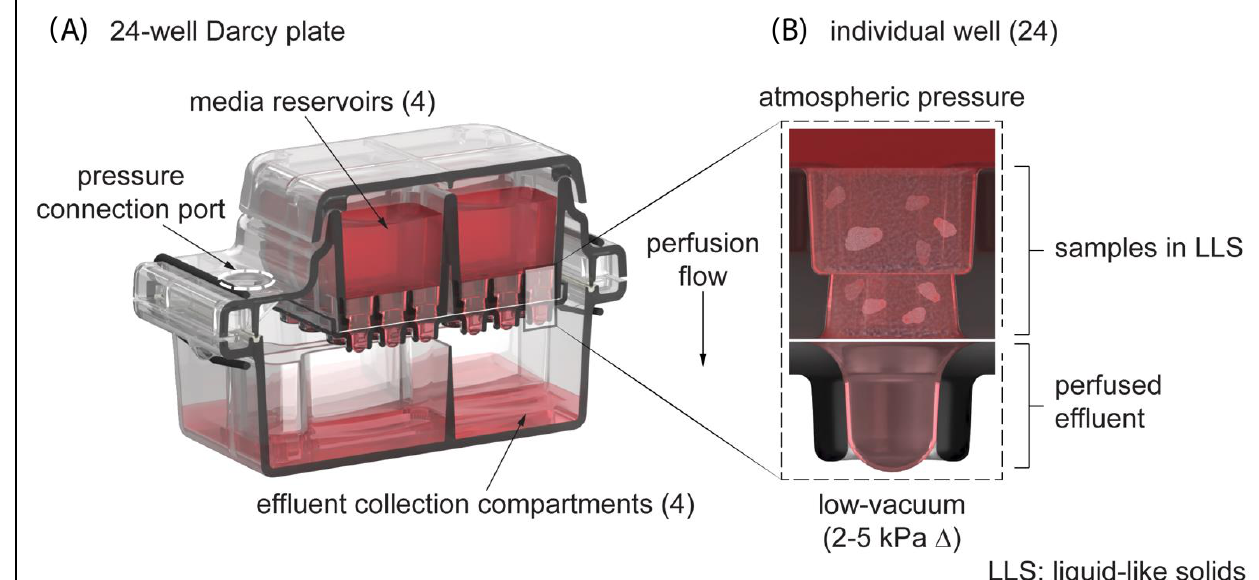
Figure 1. 24-Well Darcy Plate ( A ) A 24-well plate consists of 4 injection-molded polystyrene components: a lid, media reservoir, droplet-guiding cover, and effluent collection chambers. The lid protects the media reservoirs from sources of contamination and allows the exchange of gases. The media reservoir is divided into quadrants that each can contain up to 6 mL of culture media. ( B ) Detailed view of an individual well where samples can be suspended in LLS. A PCTE membrane is heat-sealed against the bottom surface during the plate assembly process, securing the suspension in place.